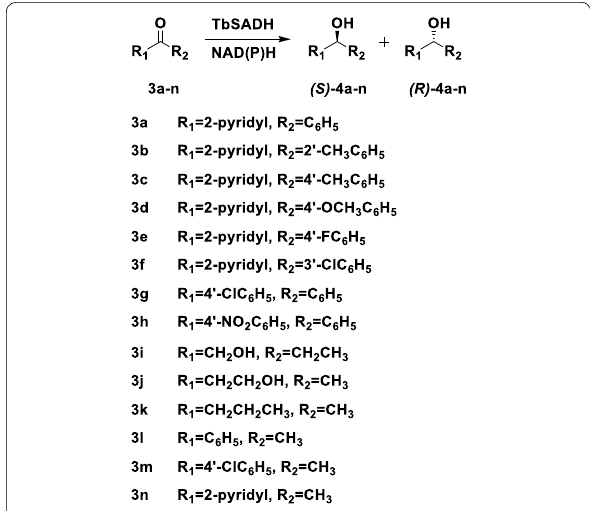
a Conversion rate (c %) and ee values were determined by chiral HPLC and GC analysis as shown in Additional file 1 b ee value was not determined if conversion is lower than